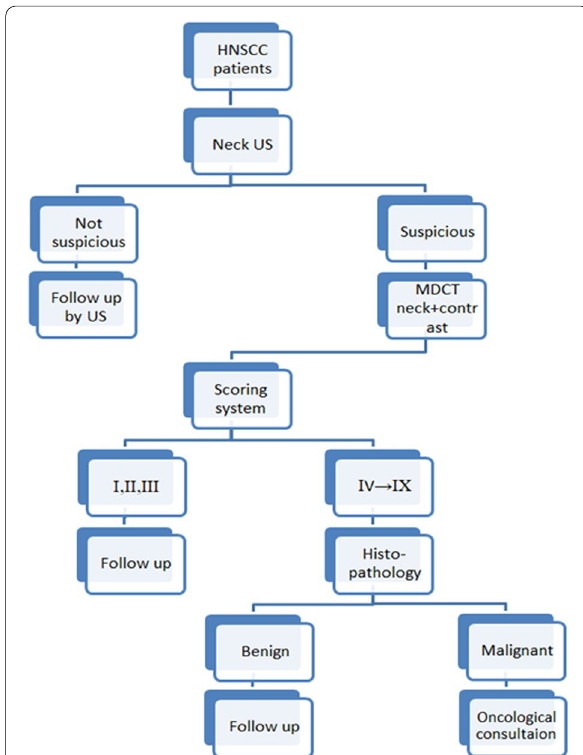
Fig. 6 The diagnostic algorithm for scoring cervical lymph nodes from head and neck squamous cell